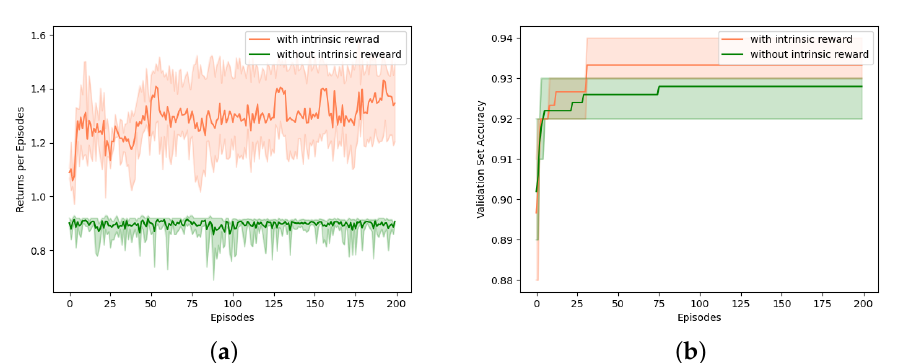
Figure 8. The performance of curiosity-driven method on dataset balance_scale. ( a ) Reward returns for each episode. The green line is the reward return using only the accuracy of the validation set, and the coral line is the reward return using both the intrinsic reward and the accuracy of the validation set. ( b ) The accuracy of the validation set corresponding to the best hyperparameter configuration found by the current